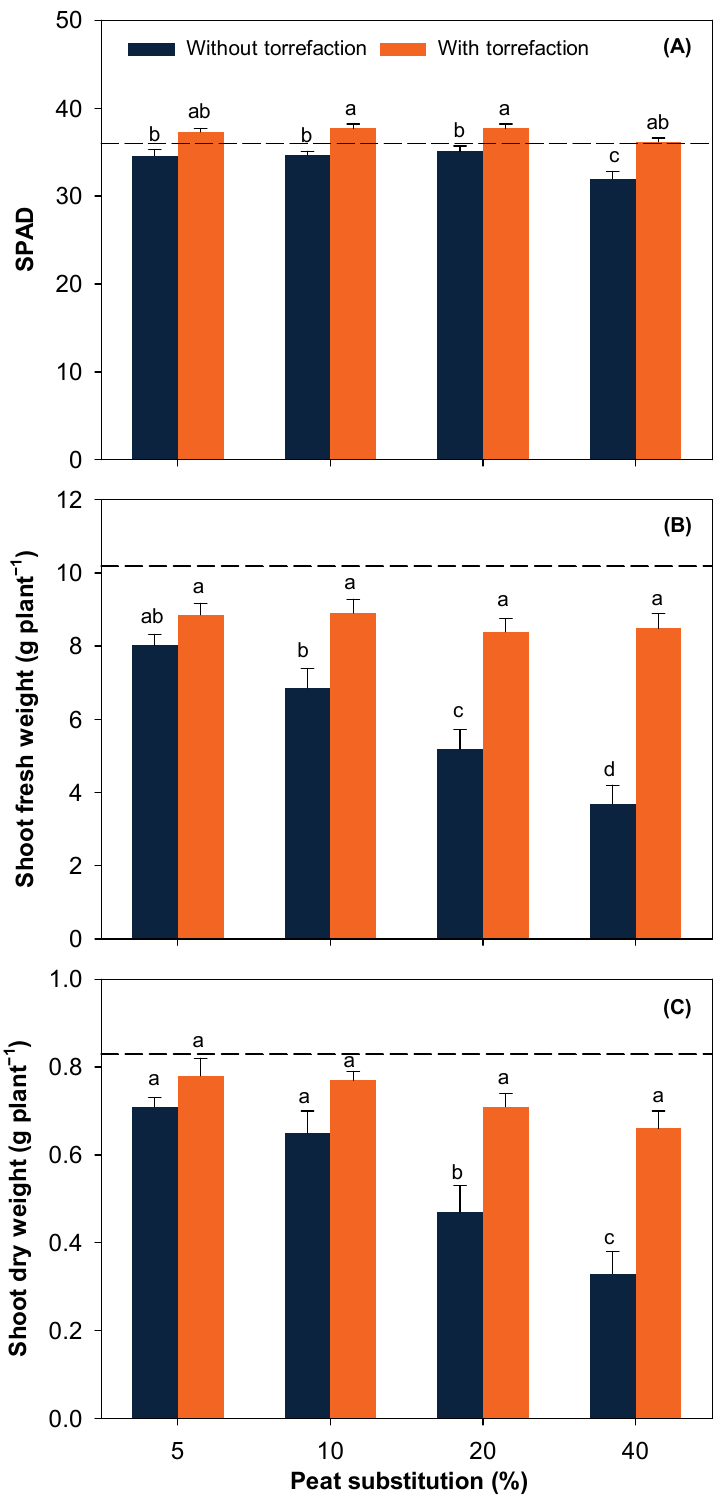
Figure 4. SPAD ( A ), shoot fresh weight ( B ), and shoot dry weight ( C ) of bok choy at harvest as affected by peat substitution × torrefaction interaction. The horizontal dash line represents bok choy grown in 100% commercial peat. Data represent mean ± SE. For each figure, means followed by different lower-case letters indicate significant difference at α =